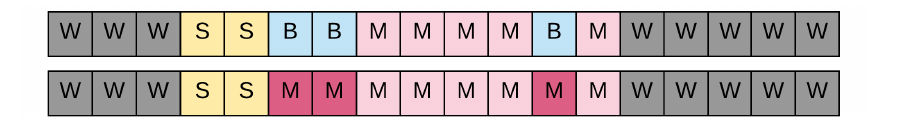
Figure 3. Results of initial classification (first row) and the Healing algorithm (second row) for the first special